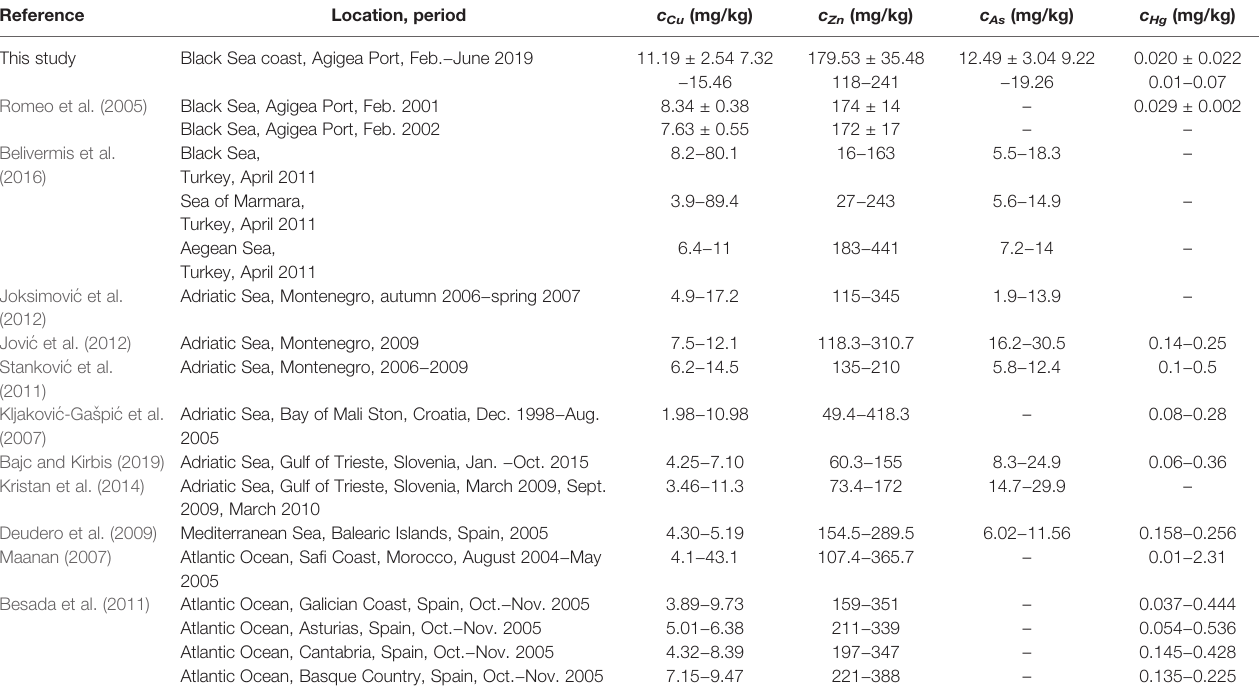
TABLE 3 | Concentrations (dry basis) of some trace elements in the soft tissue of M. galloprovincialis mussels.